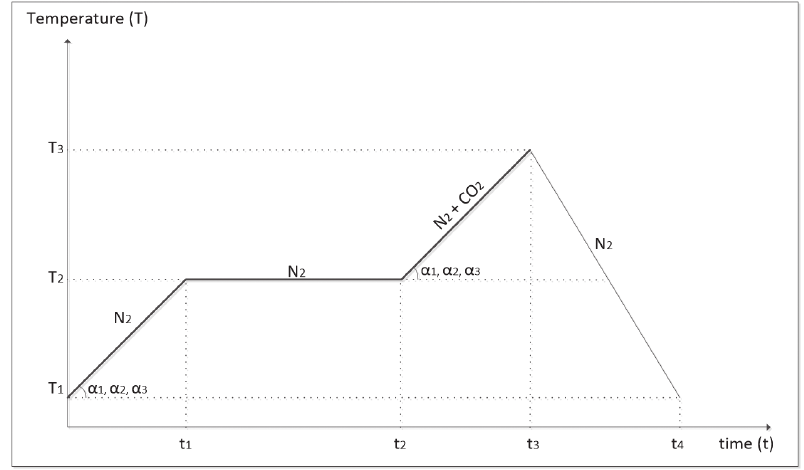
Figure 1 - Diagram of thermal degradation during AVF preparation.